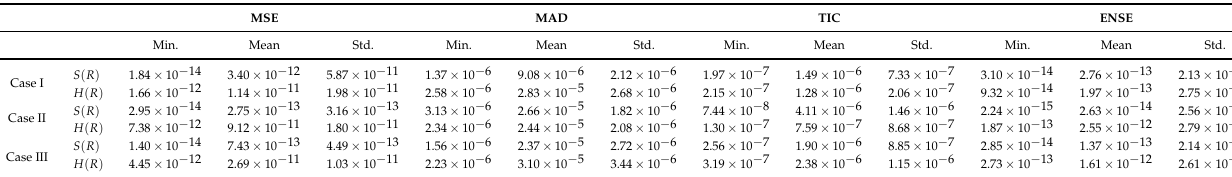
Table 5. Stability analysis on the values of performance function and performance indicators in terms of minimum, mean and standard deviations for different cases of